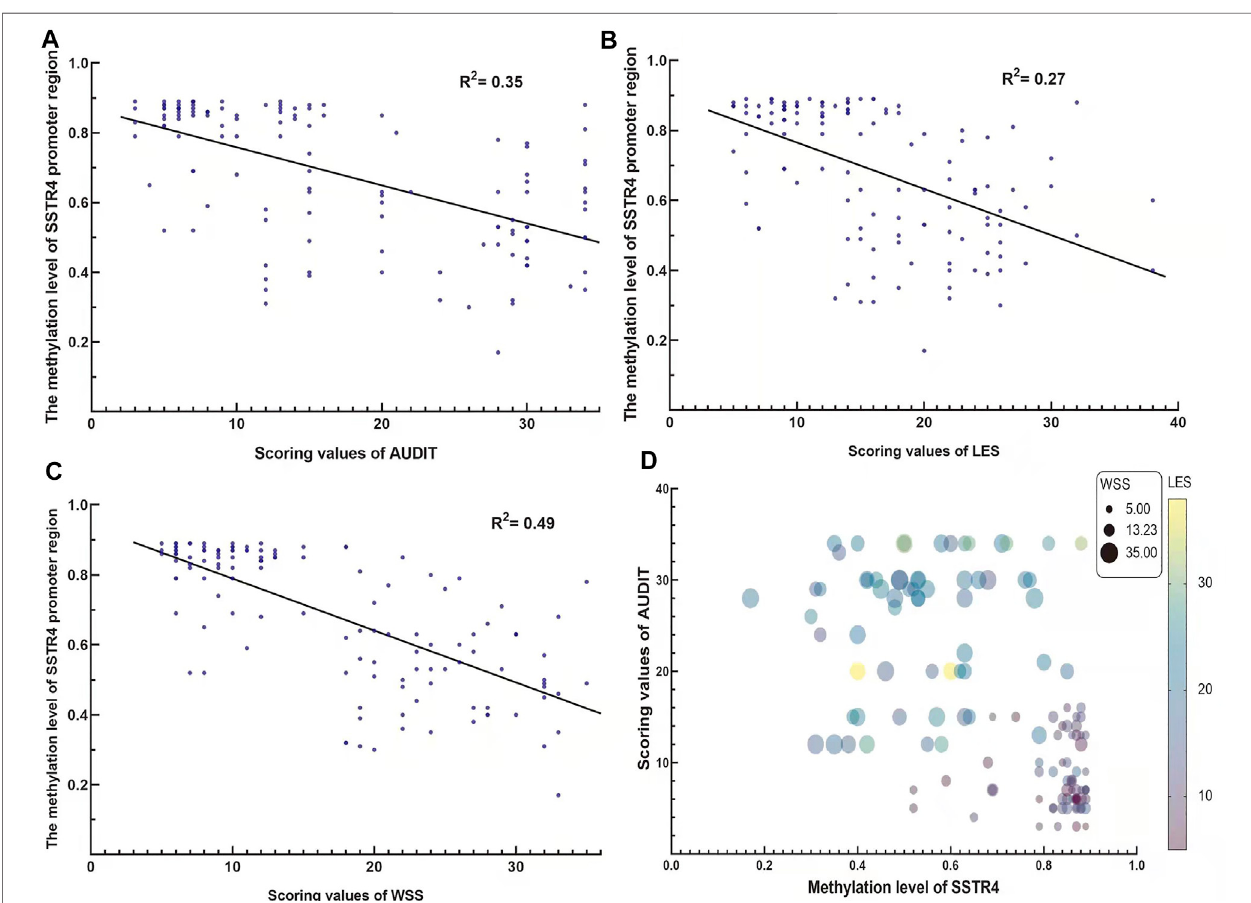
FIGURE2| Thecorrelationbetweenthemethylationvalueofthe SSTR4 promoterregionandAUDIT,LESandWSSscores. (A) Themethylationvalueofthe SSTR4 promoterregionandtheAUDITscorewerenegativelycorrelated. (B) Themethylationvalueofthe SSTR4 promoterregionandtheLESscorewerenegativelycorrelated. (C) The methylation value of the SSTR4 promoter region and the WSS score were negatively correlated. (D) Bubble plot for the visualization of association of SSTR4, AUDIT4, LES and